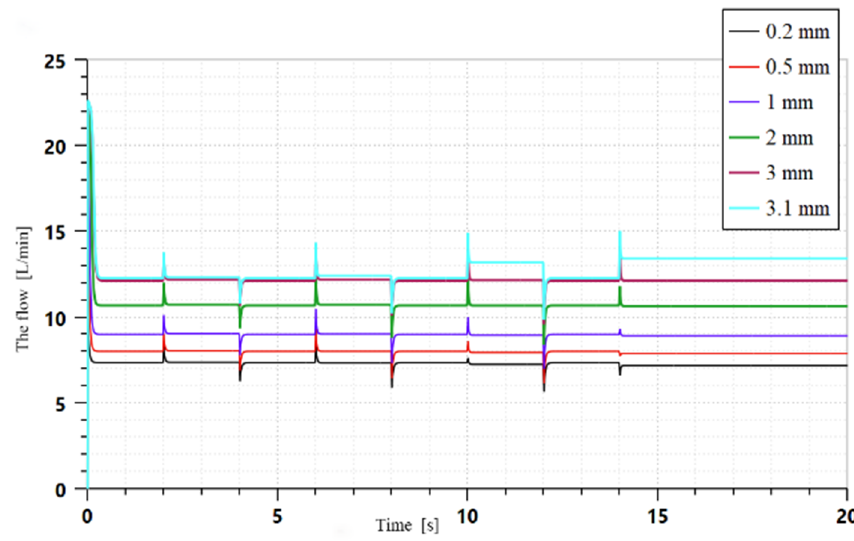
Figure 13. Influence of different initial openings on flow rate.